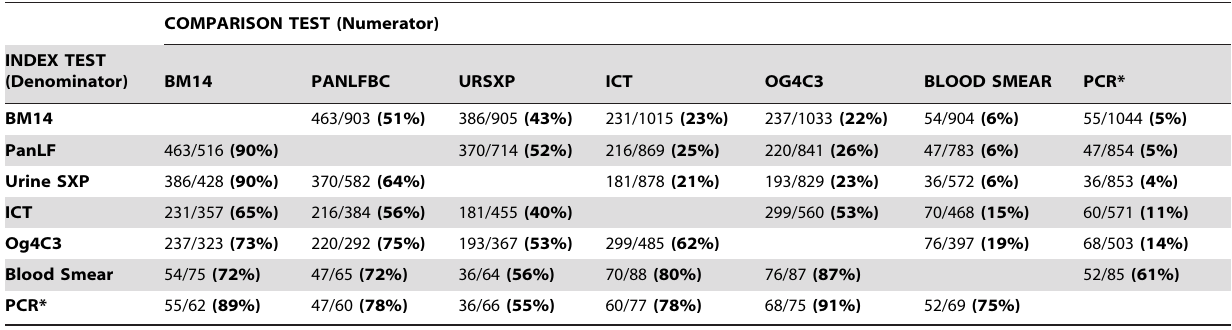
Table 10. Positive-to-positive concordance in community